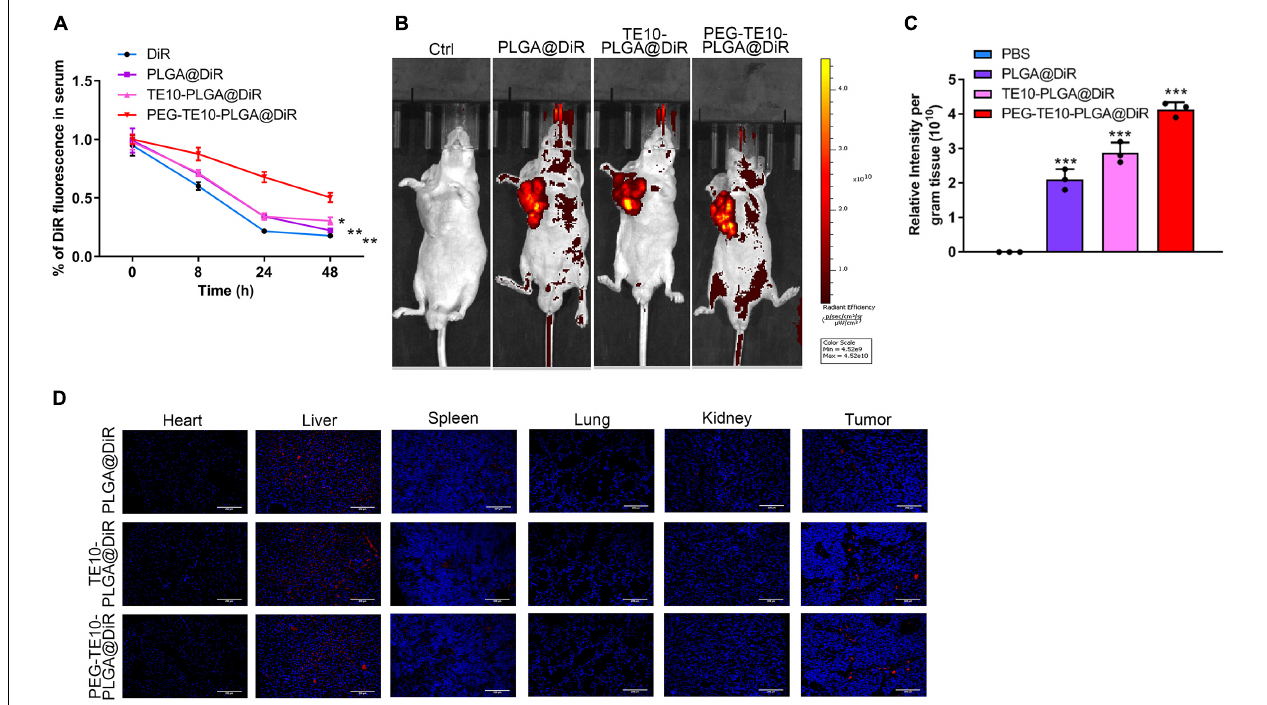
FIGURE 4 | Pharmacokinetics and biodistribution of PMPNs. (A) Changes of DiR fluorescence in serum of mice after treatment with DiR, PLGA@DiR, TE10-PLGA@DiR and PEG-TE10-PLGA@DiR. In vivo fluorescence imaging (B) and quantification of mice (C) . (D) Biodistribution of PLGA@DiR, TE10-PLGA@DiR and PEG-TE10-PLGA@DiR in main organ and tumor of mice. DiR fluorescence intensity was then quantified. *** P < 0.001 vs. control